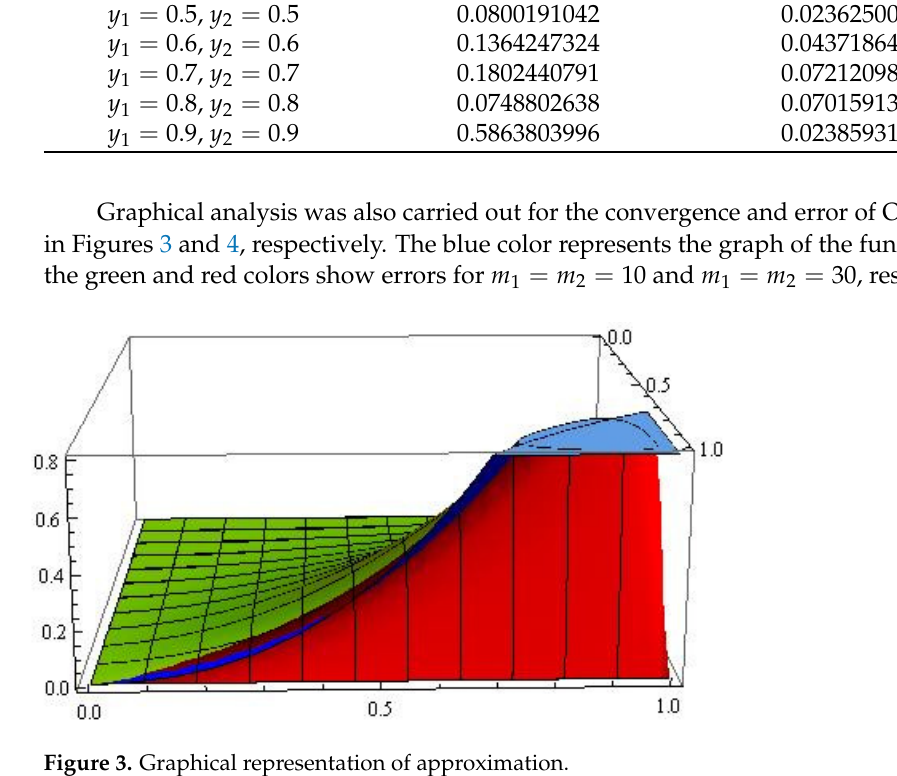
Figure 3. Graphical representation of approximation.